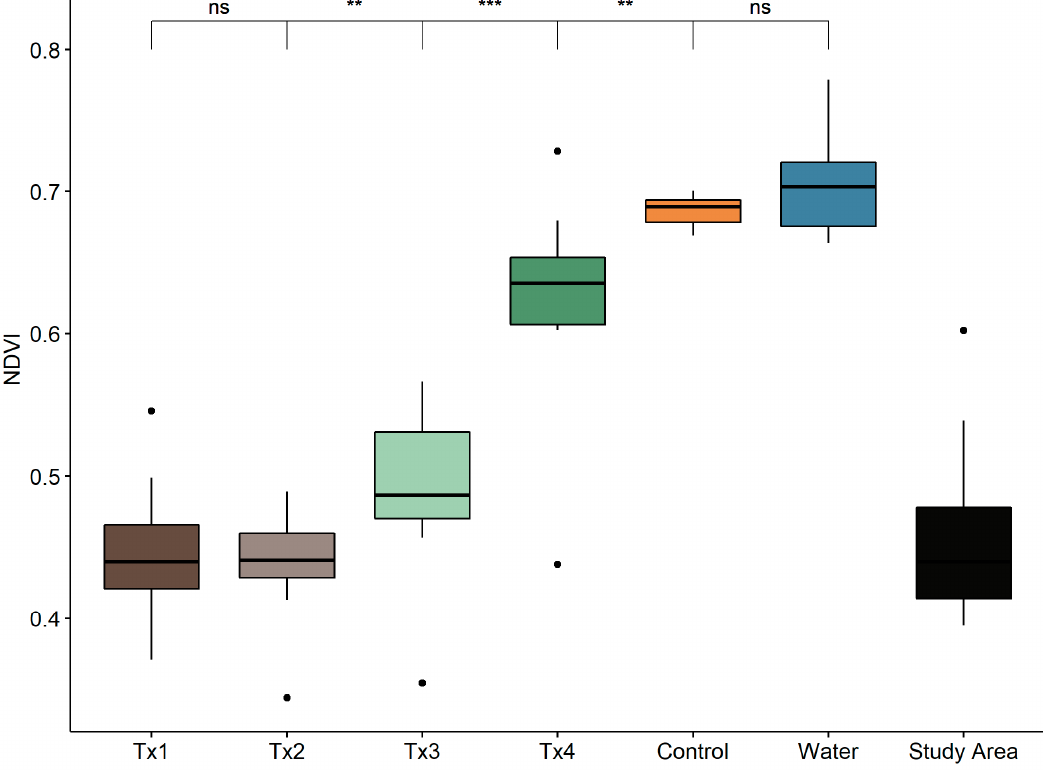
Figure 4. Spectral index value for all pixels (Day 1 and Day 2) by treatment: Difference between pairs of treatments determined from Wilcox test are indicated at the top of each pair: ns = not significant at 0.05 significance level ( p > 0.05), *: p ≤ 0.05 **: p ≤ 0.01, ***: p ≤ 0.001.